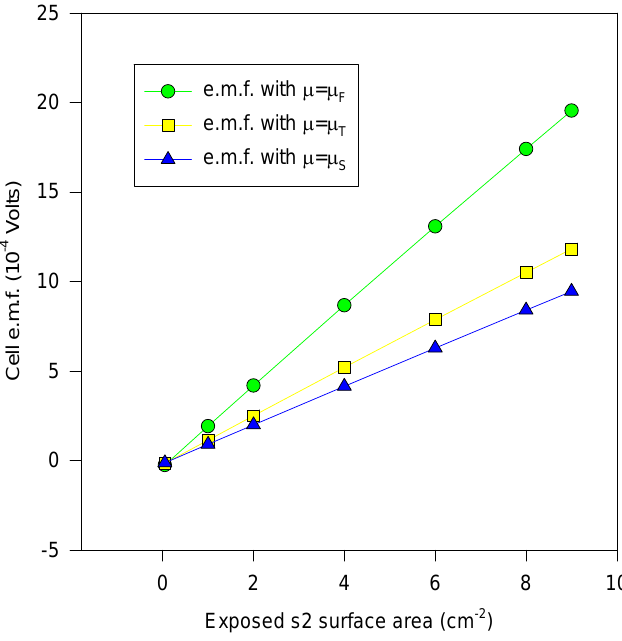
Figure 6. Variation of cell e.m.f. with area of electrode s2 exposed to 0.05 m aq.